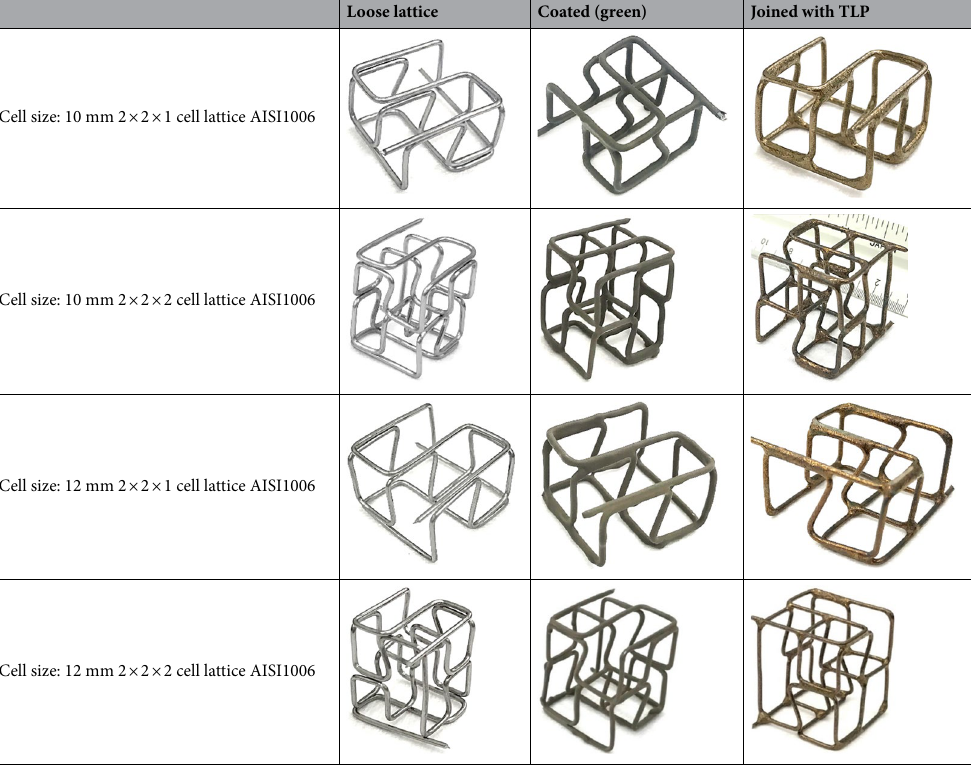
Table 2. Fabricated and joined cubic lattice structures.